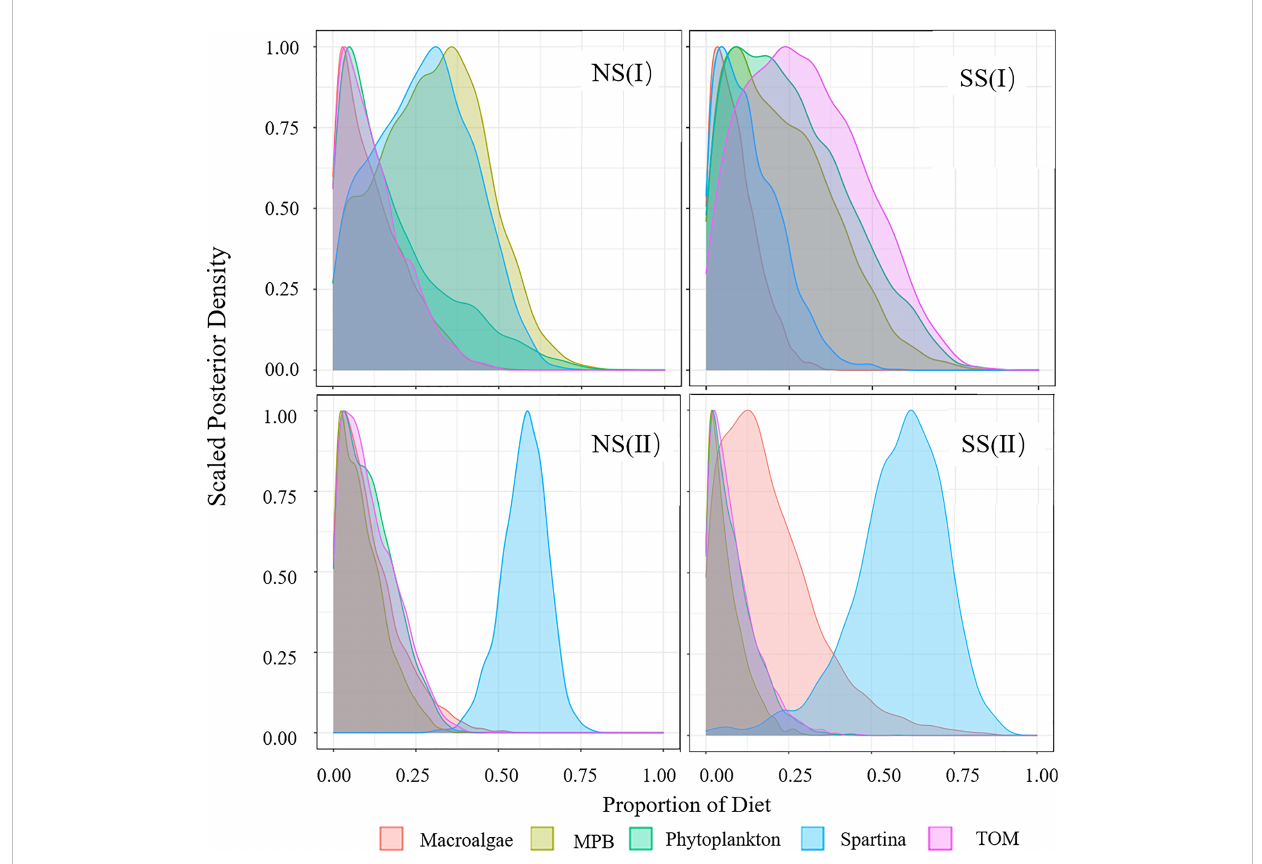
FIGURE 4 Diet Proportion of omnivorous fi sh. (I) Flood season; (II) Non- fl ood season; (NS) Northern shore; (SS) Southern